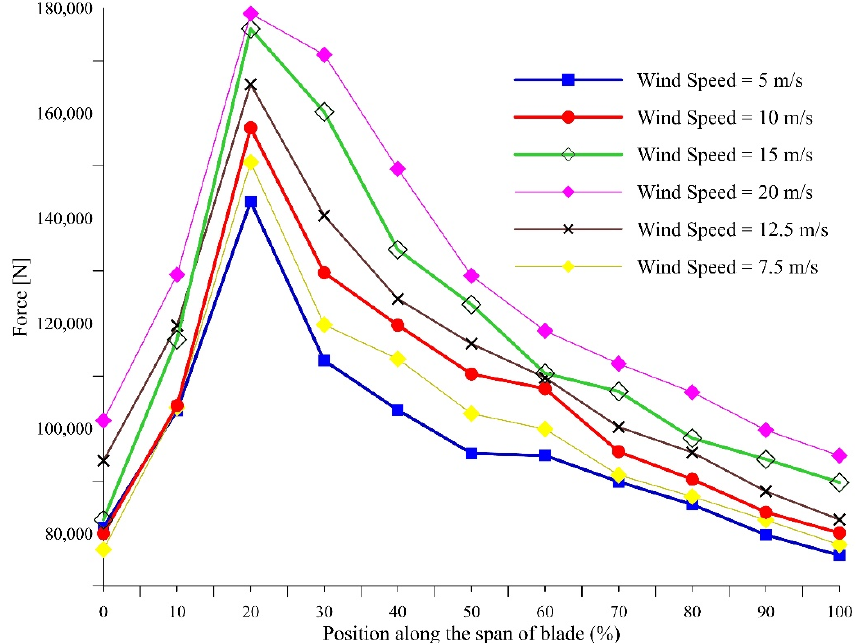
Figure 12. Axial force distribution along the span at the centerline of span for 8° at various wind speeds.